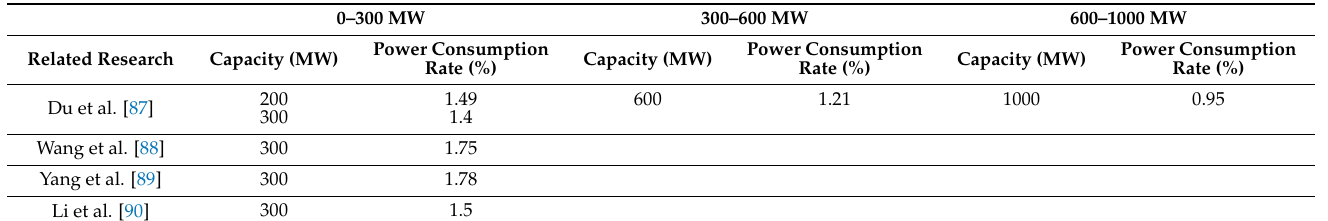
Table A2. The reference value of power consumption rate of desulfurization